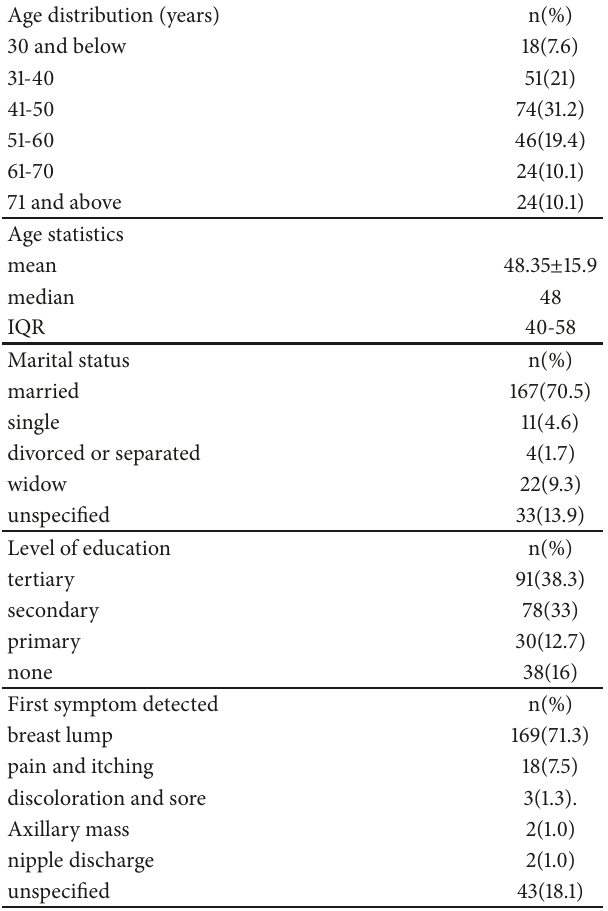
Table 1: Sociodemographics and distribution of the first symptom: Themodal agerange was the5th decade.Themajority of thepatients were married. Level of education was tertiary or secondary in the majority. Breast lump was the firstsymptom noticed by the